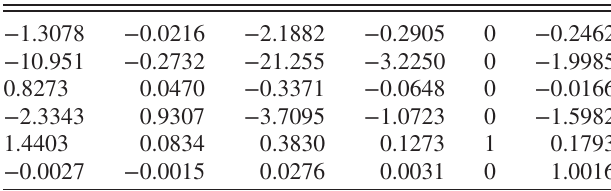
TABLE III. Transfer matrix R of C1 ( j R j ¼ 1 . 00 ).